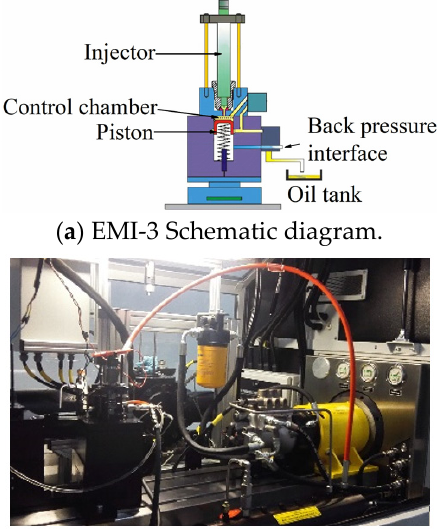
Figure 6. The diagram of common rail test system. Table 2. Test instruments and accuracy.